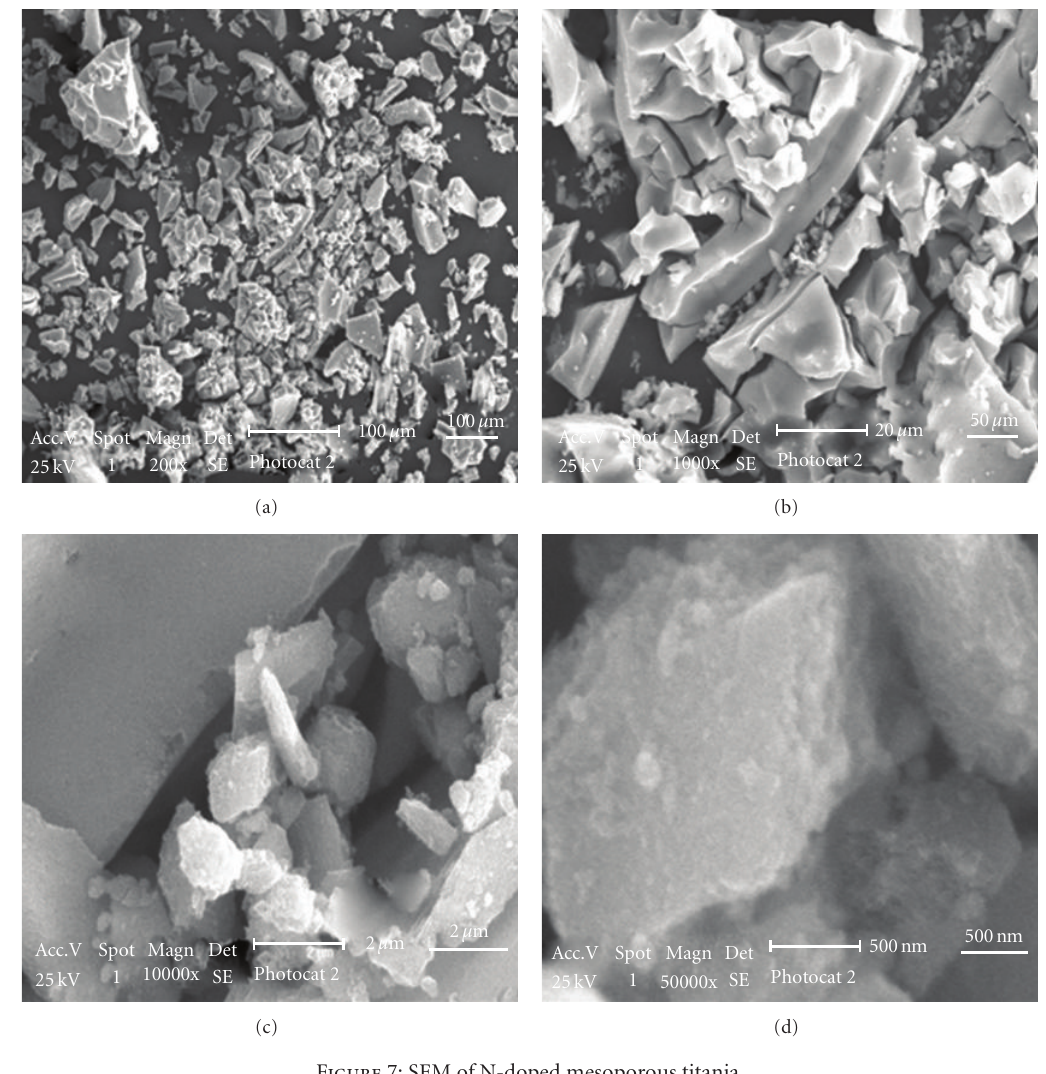
Figure 7: SEM of N-doped mesoporous